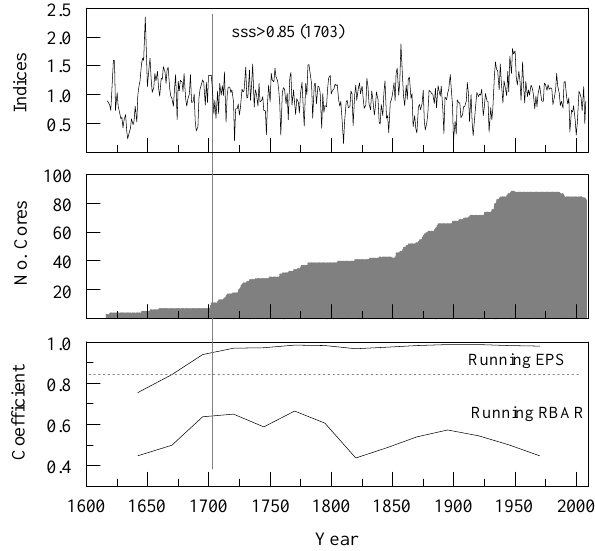
Fig. 3. (a) The regional tree-ring chronology of Lingkong Moun- Fig. 3 (a) The regional tree-ring chronology of Lingkong Mountain, (b) number of tain, (b) number of cores and (c) EPS and RBAR statistics. cores and (c) EPS and RBAR statistics.